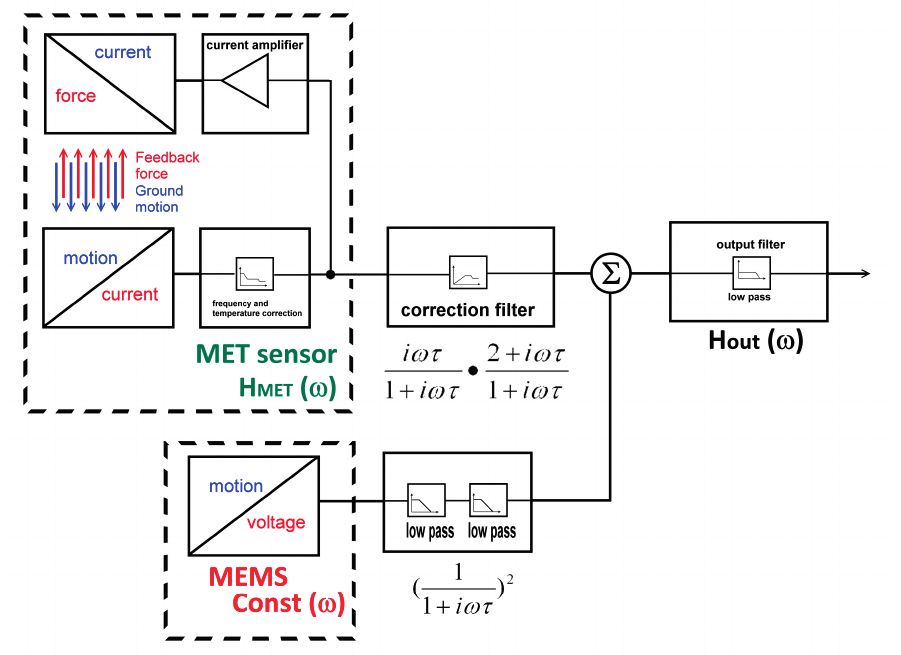
Figure 6. Block diagram for a combined